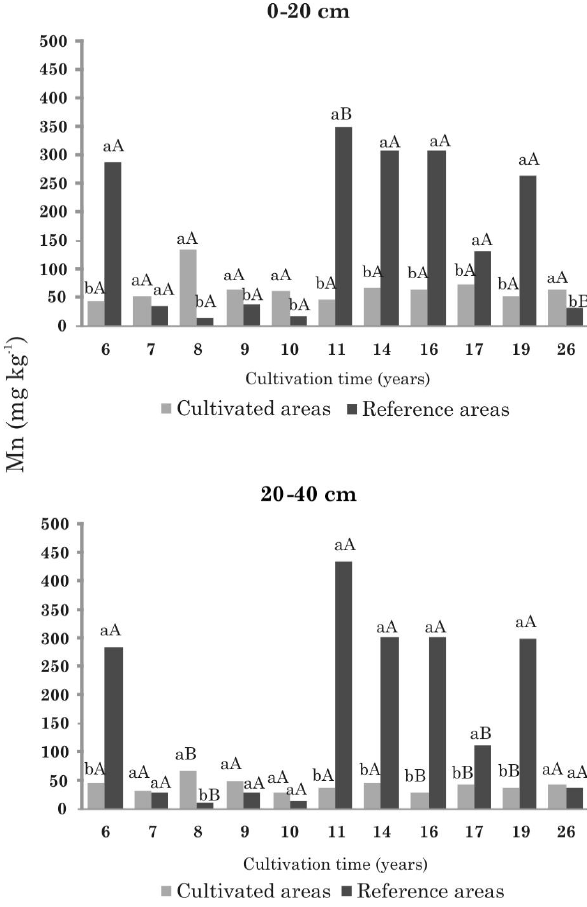
Figure 5. Total contents of Fe in cultivated (CA) and reference areas (RA) in two layers (0-20 and 20- 40 cm) after different cultivation periods. Means followed by lowercase letters between environments (CA and RA) and capital letters between layers (0-20 and 20-40) did not differ statistically by Tukey’s test (p (cid:172)(cid:31)(cid:172)